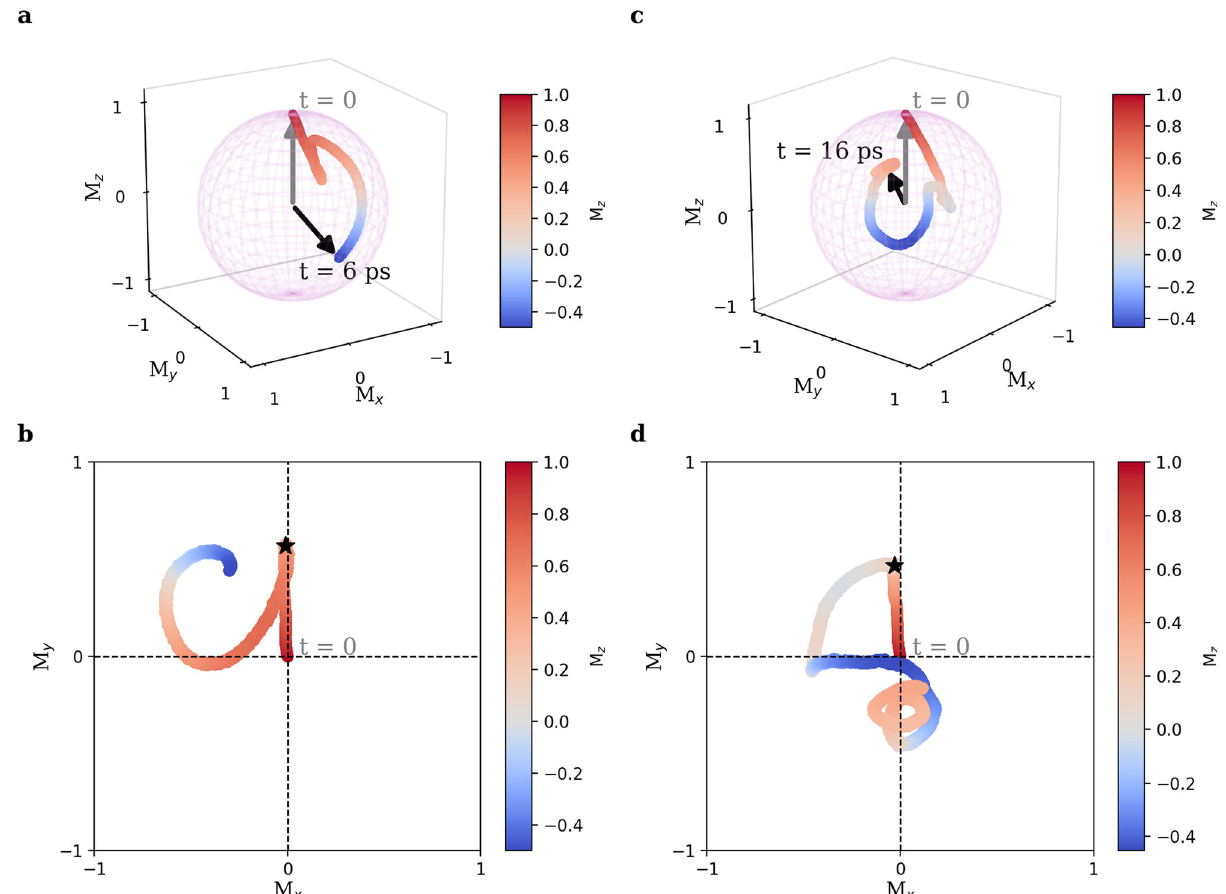
Fig. 3 Three-dimensional ultrafast magnetization dynamics of bulk Ni. a Trajectory of the magnetization vector excited by a 100 fs pulse with the intensity of E 0 = 6.79 × 10 9 V m − 1 (7 E * in Fig. 2d), with the respective associated projection on the xy -plane in ( b ). c Trajectory of the magnetization vector excited by a 100 fs pulse with the intensity of E 0 = 9.7 × 10 9 V m − 1 (10 E * in Fig. 2d), with the respective associated projection on the xy -plane in ( d ). The color maps illustrate the z -component of the magnetization and the star indicates the end of the